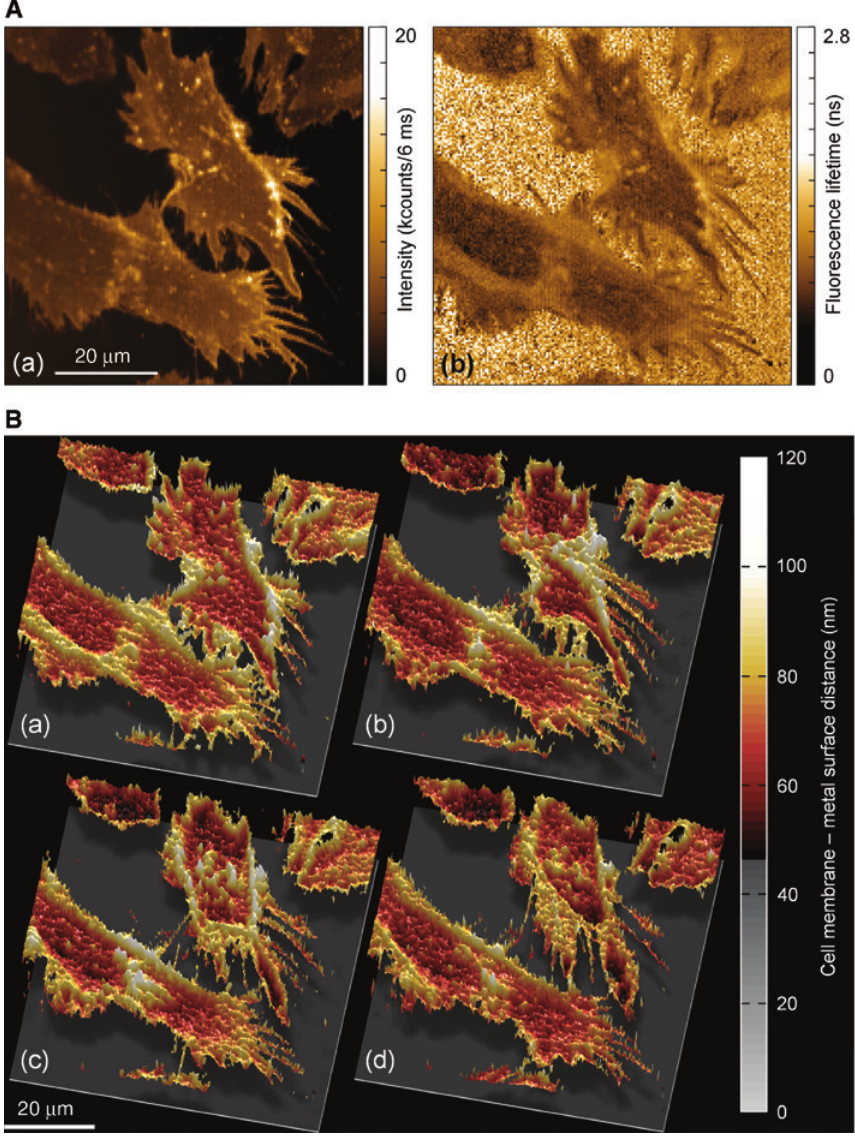
Figure 3: Height profiling of the basal membrane of adherent cells. (A) Simultaneously acquired fluorescence intensity (a) and lifetime (b) images of the basal membrane of living MDA-MB-231 cells grown on a gold-covered glass substrate and stained with CellMask Deep Red plasma membrane stain (Invitrogen). (B) Three-dimensional profiles computed from fluorescence lifetime images sequentially recorded with 10-min delays. Data taken from